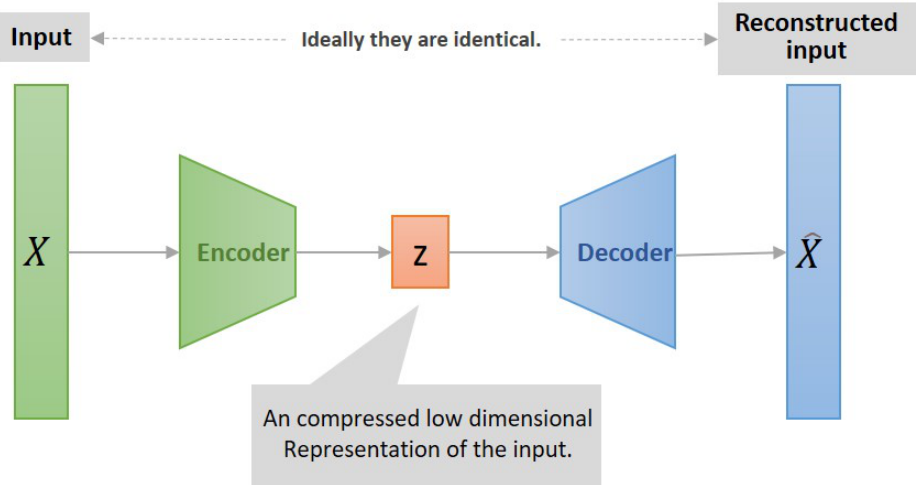
Figure 3. Structure of the proposed variational autoencoder. The encoder accepts the input data X and outputs the distribution of the hidden variable. The decoder accepts the mean of the hidden variable Z and then outputs the reconstructed sample of the input data ( ˆ X ). X and ˆ X should be as close as